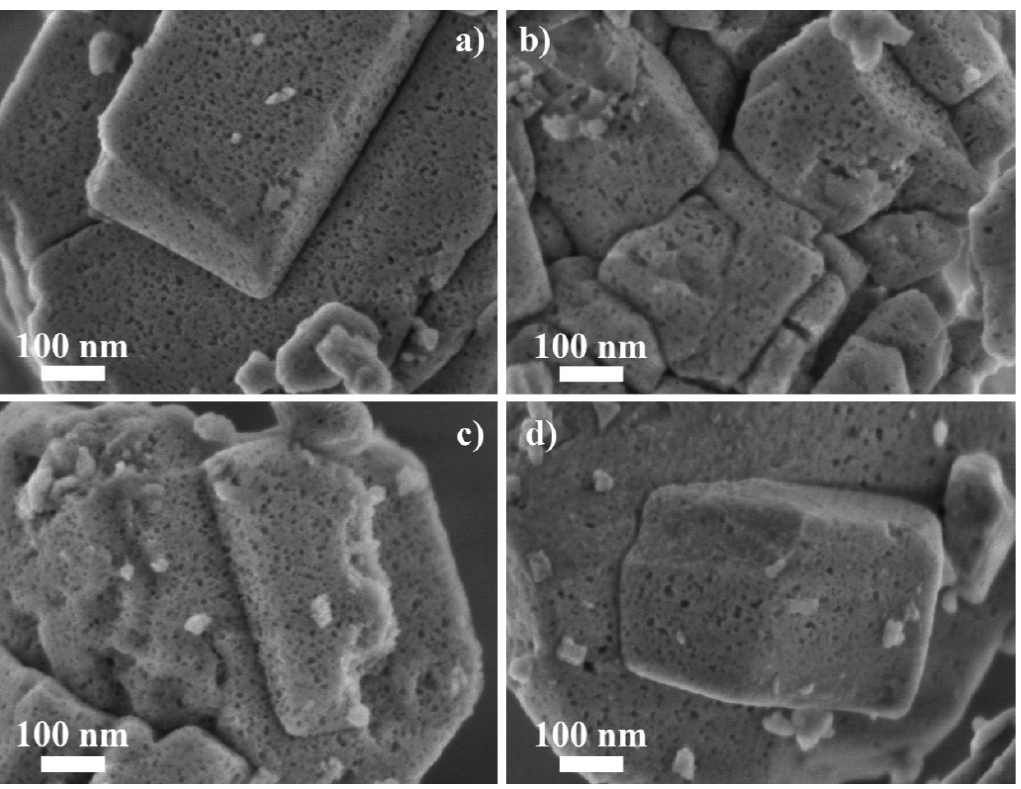
Figure 4. FESEM micrographs of fluorination-alkaline treated samples. ( a ) AT(65,60)-FZ5a, ( b ) AT(65,60)-